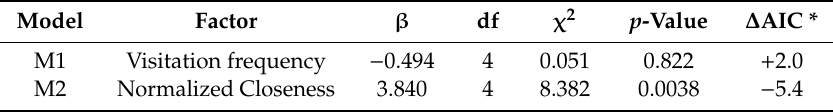
Table 1. Comparison of the null model and two generalized linear mixed models with di ff erent fixed factors to explain parasite prevalence, i.e., Neogregarinorida and Trypanosomatidae taken together (binomial logit distributed) for all model study sites served as a random e ff ect, and flower species was nested within the study site. Models were compared based upon the Akaike information criterion. * ∆ AIC with regard to the null model (i.e., model that included the same random e ff ect as the other models, yet no fixed